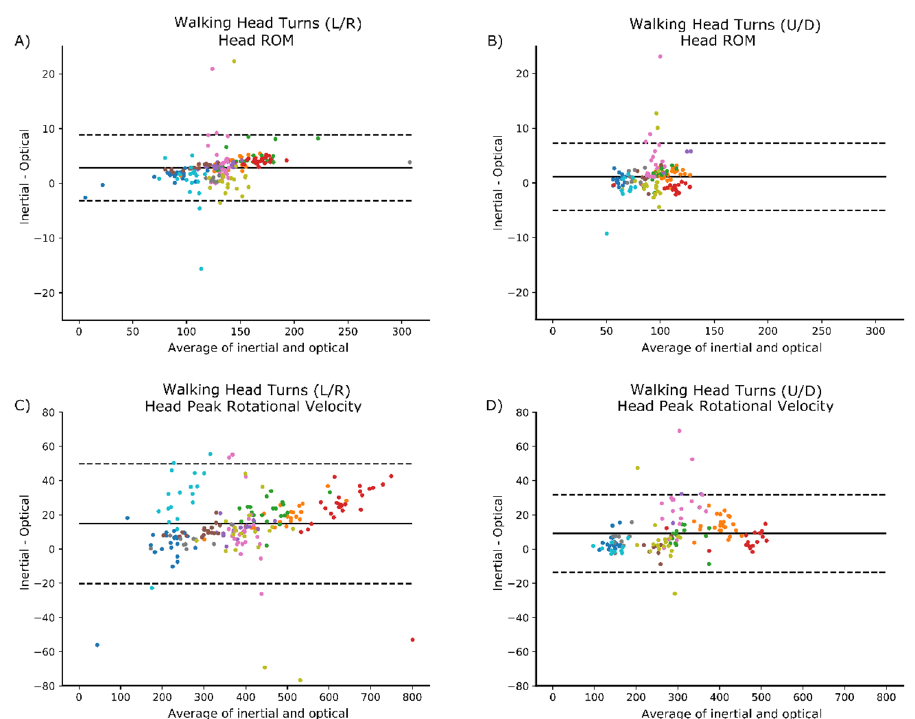
Figure 3. Bland-Altman plots for walking conditions. Each participant is represented by a different color within the plot. ( A ) ROM, walking with head turns (L/R); ( B ) ROM, walking with head turns (U/D); ( C ) peak rotational velocity, walking with head turns (L/R); and ( D ) peak rotational velocity, walking with head turns (U/D). Solid lines represent the mean difference, and dashed lines represent ± 1.96 × SD.